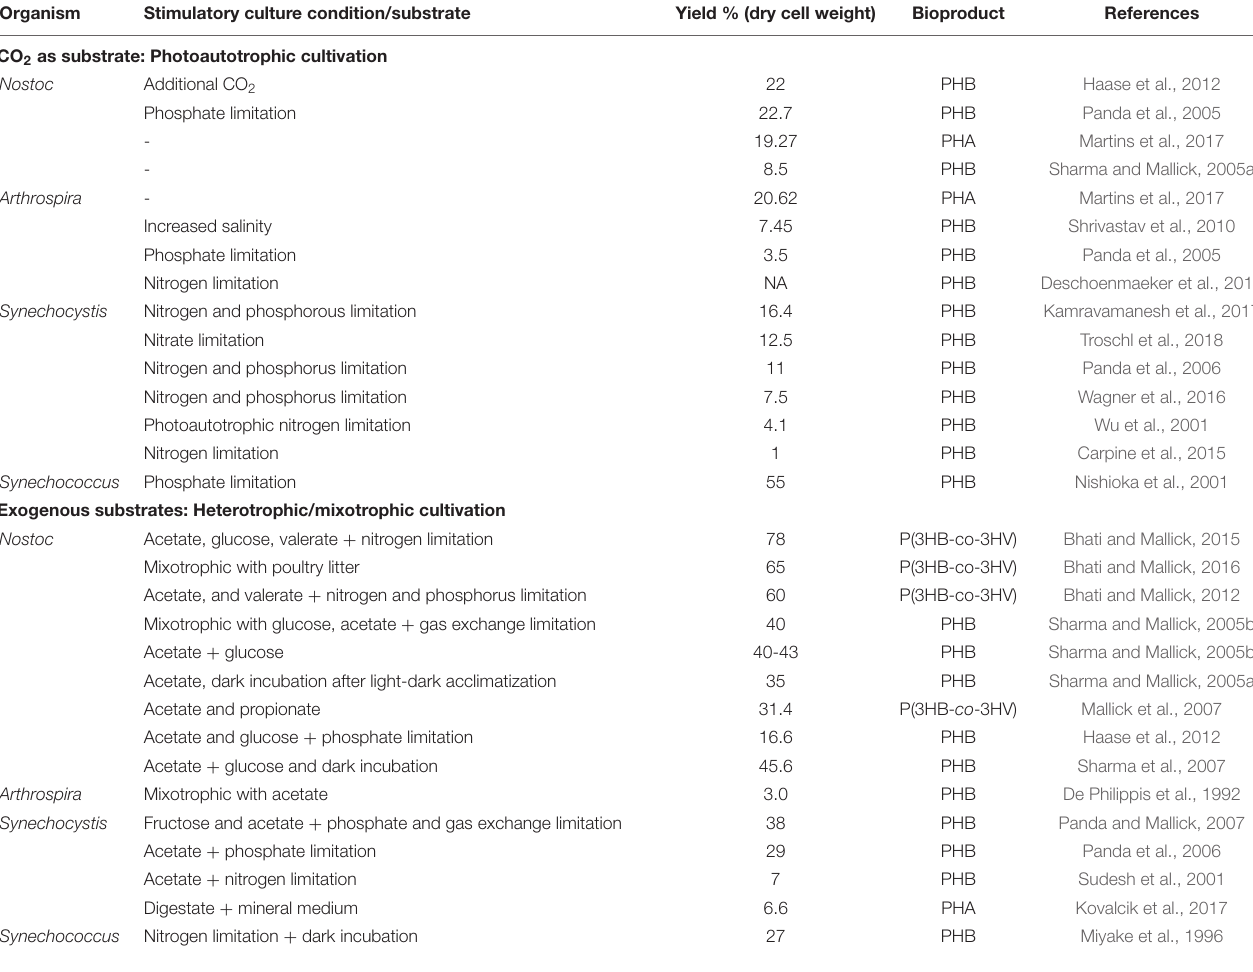
TABLE 1 | PHA production from cyanobacteria under different cultivation conditions (I): Nostoc , Arthrospira , Synechocystis , and Synechococcus .